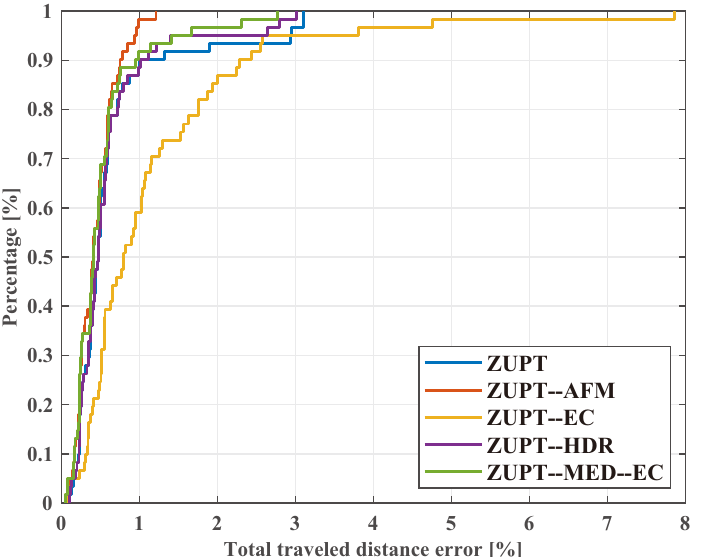
Figure 16. TTDE CDF curves of the different frameworks on all indoor and outdoor loop